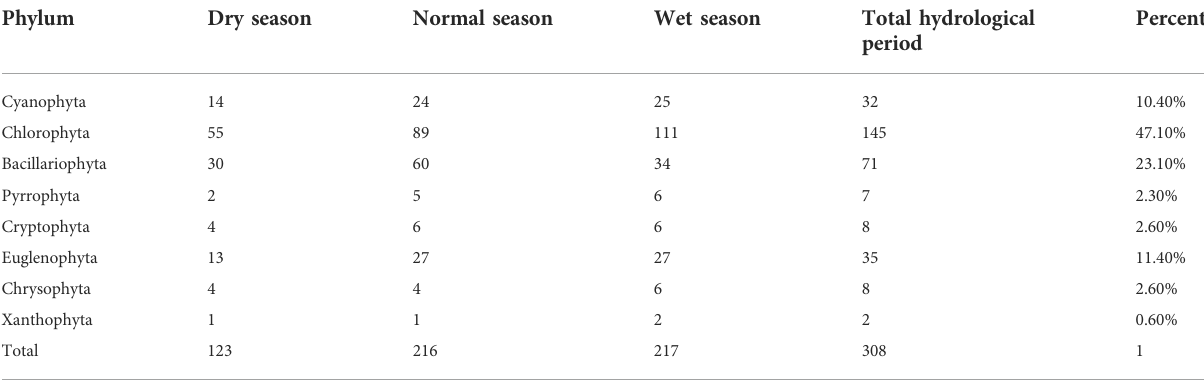
TABLE 1 Species number of phytoplankton in different hydrological